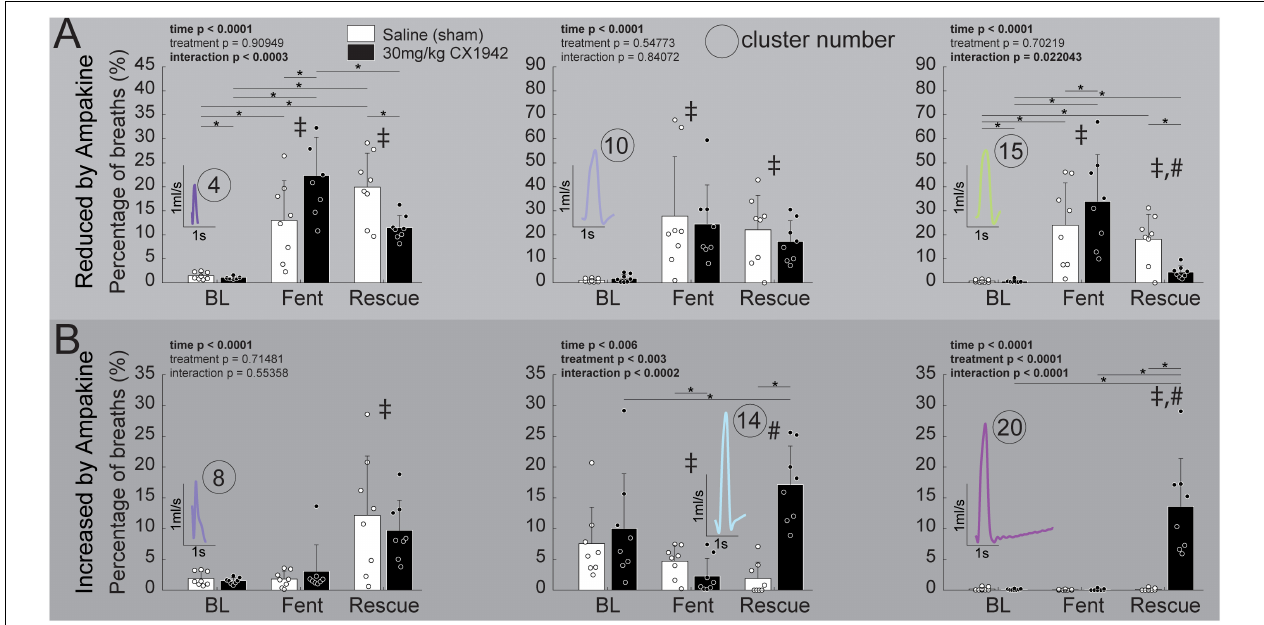
FIGURE 6 | Prevalence of respiratory waveform clusters that were strongly affected by ampakine CX1942 injection. Comparison of the prevalence of clusters that were either (A) reduced ( n = 8/treatment group) or (B) increased ( n = 8/treatment group) by ampakine CX1942; between the control (saline) and high dose (30 mg/kg) ampakine groups. These six clusters were identified within the high dose (30 mg/kg) ampakine group as being affected by ampakine (see text). All comparisons were 2-way ANOVAs with Tukey–Kramer post hoc tests to control for multiple comparisons (* p < 0.05) were run if the interaction p < 0.05; if there was a significant ( p < 0.05) main effect of time (BL, Fent, Rescue), a ‡ or a # indicates a significant ( p < 0.05) pairwise comparison between baseline (BL) or fentanyl (Fent),